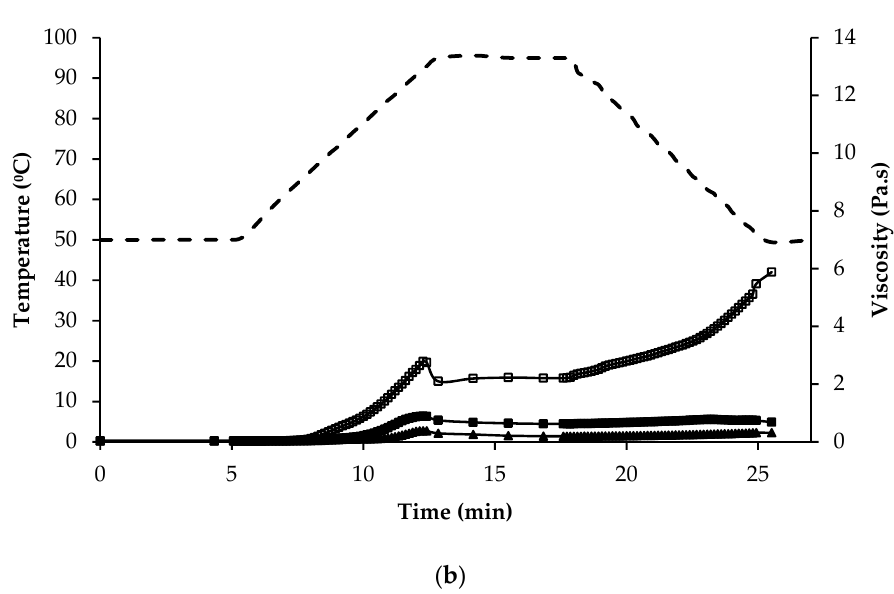
Figure 5. Temperature (dashed line) and viscosity (symbols) at various stages of the pasting regime of ( a ) regular protein containing flours: quinoa wholegrain flour ( ), quinoa dehulled flour ( ).